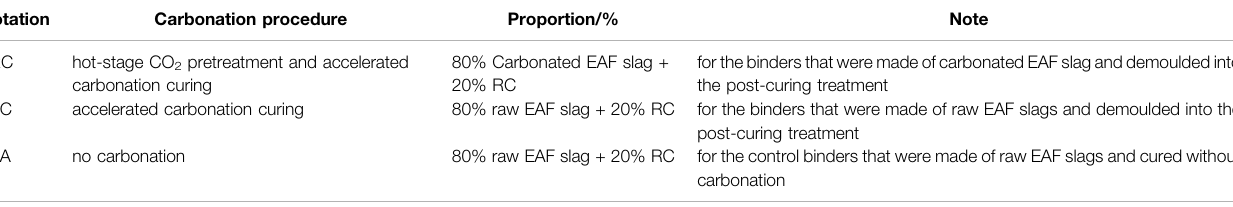
TABLE 2 | Carbonation procedures.